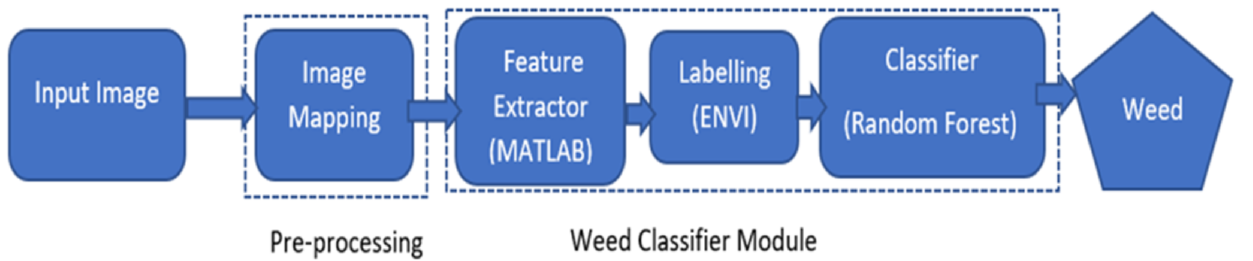
Figure 1. The workflow of our proposed